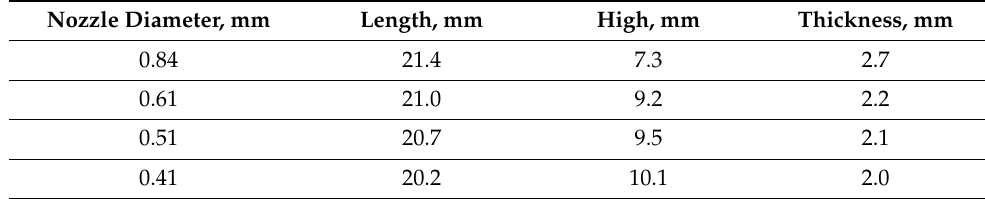
Table 3. Size of the 3D-printed model.